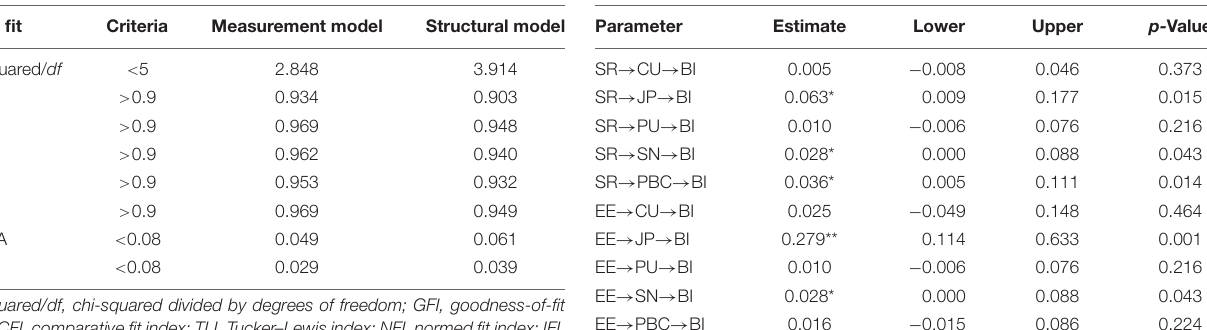
TABLE 5 | Analysis of mediation